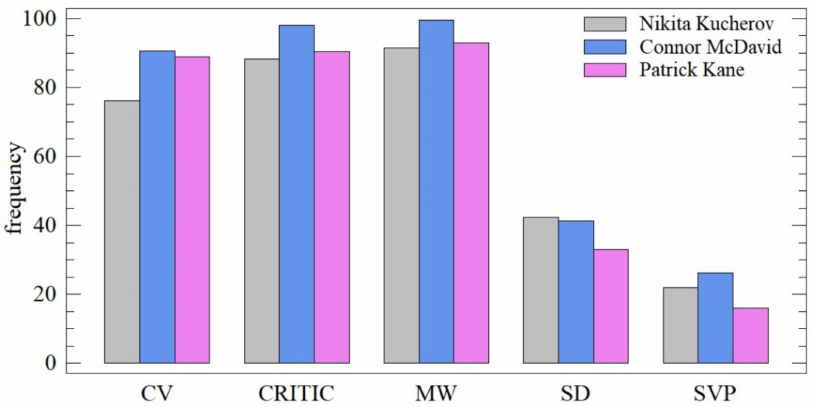
Figure 14. Share of the rankings for selected players and the best player within the completed analysis (TOPSIS combined with CV, CRITIC, MW, SD and